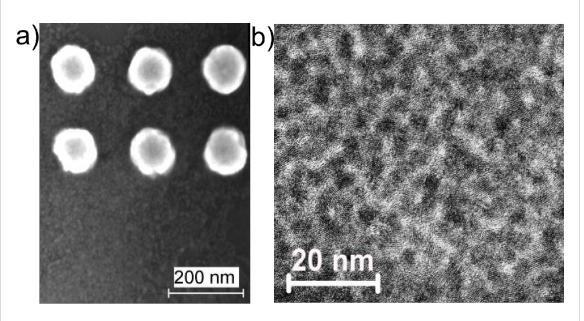
Figure 2: (a) SEM image of a single monolayer of CdSe NCs deposited on Si (bottom) and Au nanocluster arrays with a pitch of 200 nm (top). (b) HR-TEM image of a single monolayer of CdSe NCs formed on a carbon-coated Cu